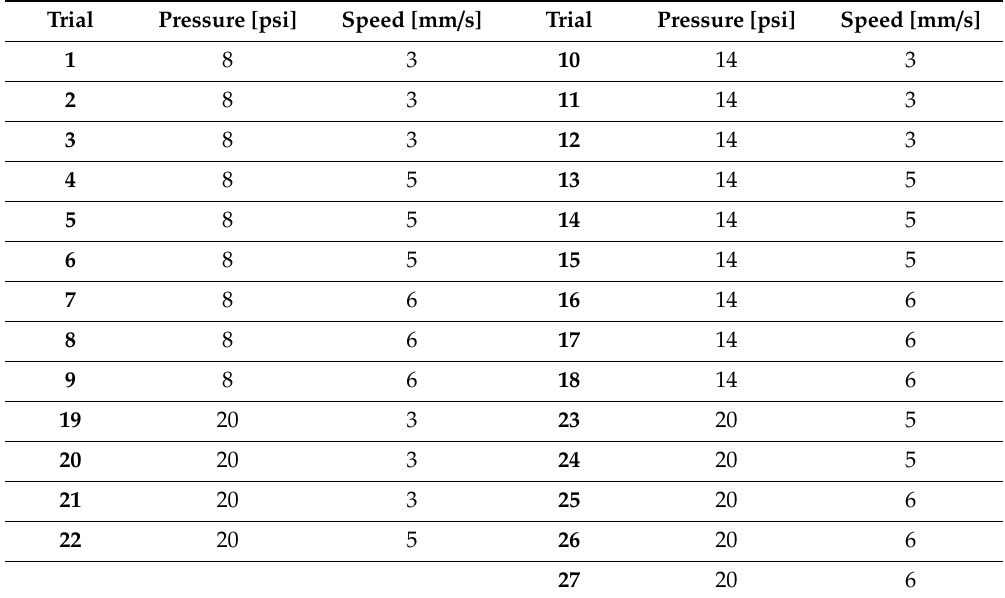
Table 1. List of the conducted print trials at varying settings for extrusion pressure and print speed.